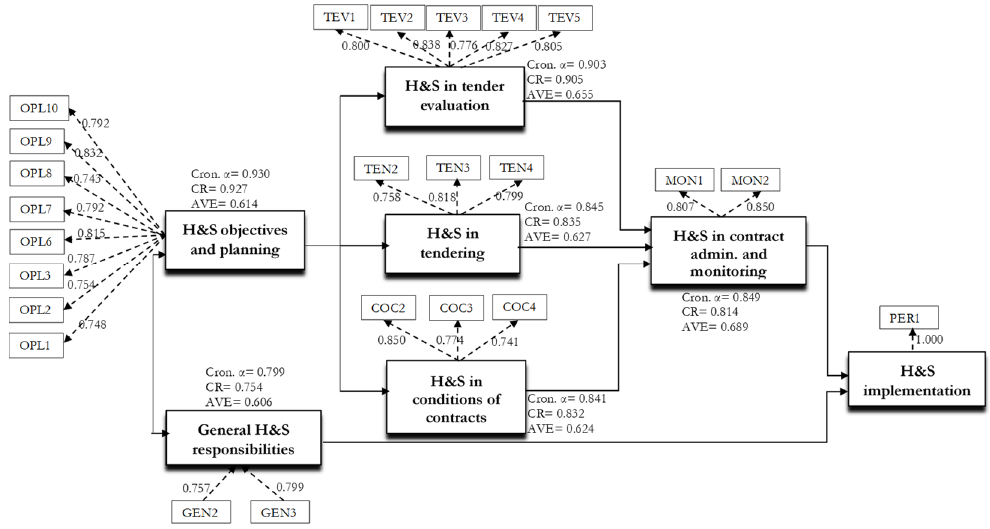
Figure 2. Measurement model with loadings.